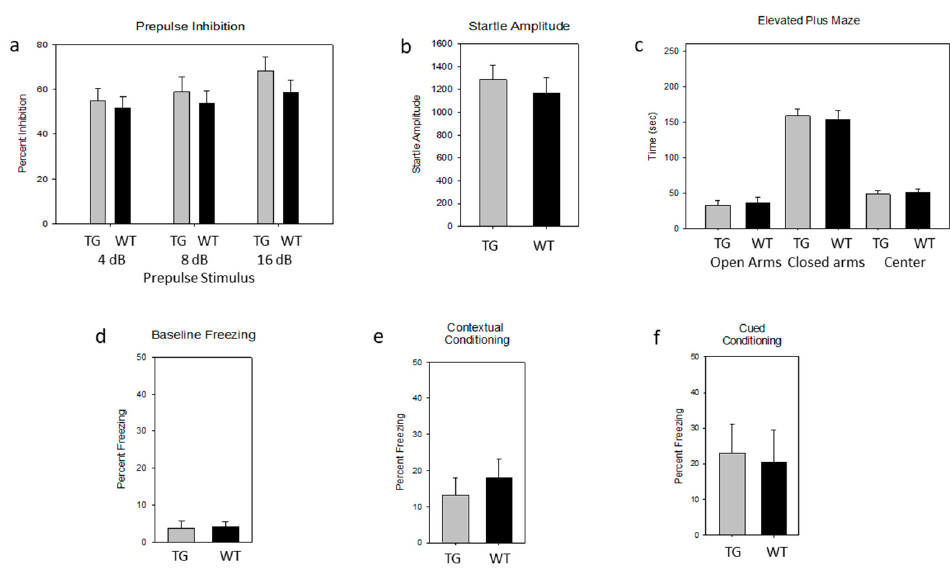
Figure 3. PDE4D5-D556A transgenic mice show no clear differences in prepulse inhibition, anxiety, or fear conditioning. Black bars: Wild-type (WT). Grey bars: PDE4D5-D556A (TG). Sexes are pooled. Data are means ± SE. ( a ) Prepulse inhibition, percent inhibition with progressive stimulus (percent inhibition at prepulses of 4, 8, and 16 dB over background). ( b ) Prepulse inhibition, amplitude of startle response. ( c ) Elevated plus maze, time in each arm. ( d ) Fear conditioning, baseline freezing. ( e ) Fear conditioning, contextual conditioning. ( f ) Fear conditioning, cued conditioning.